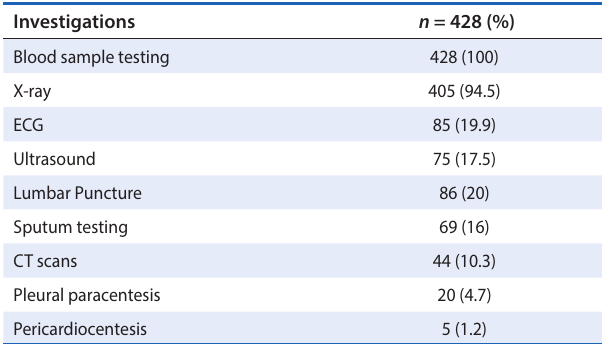
Table 3: HIV-positive cohort: investigations and procedures performed in the ED Investigations